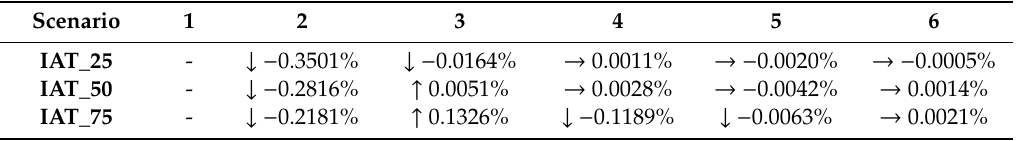
Table 3. Deviation of gross domestic product (GDP) between iterations for three decoupling factors. Scenario